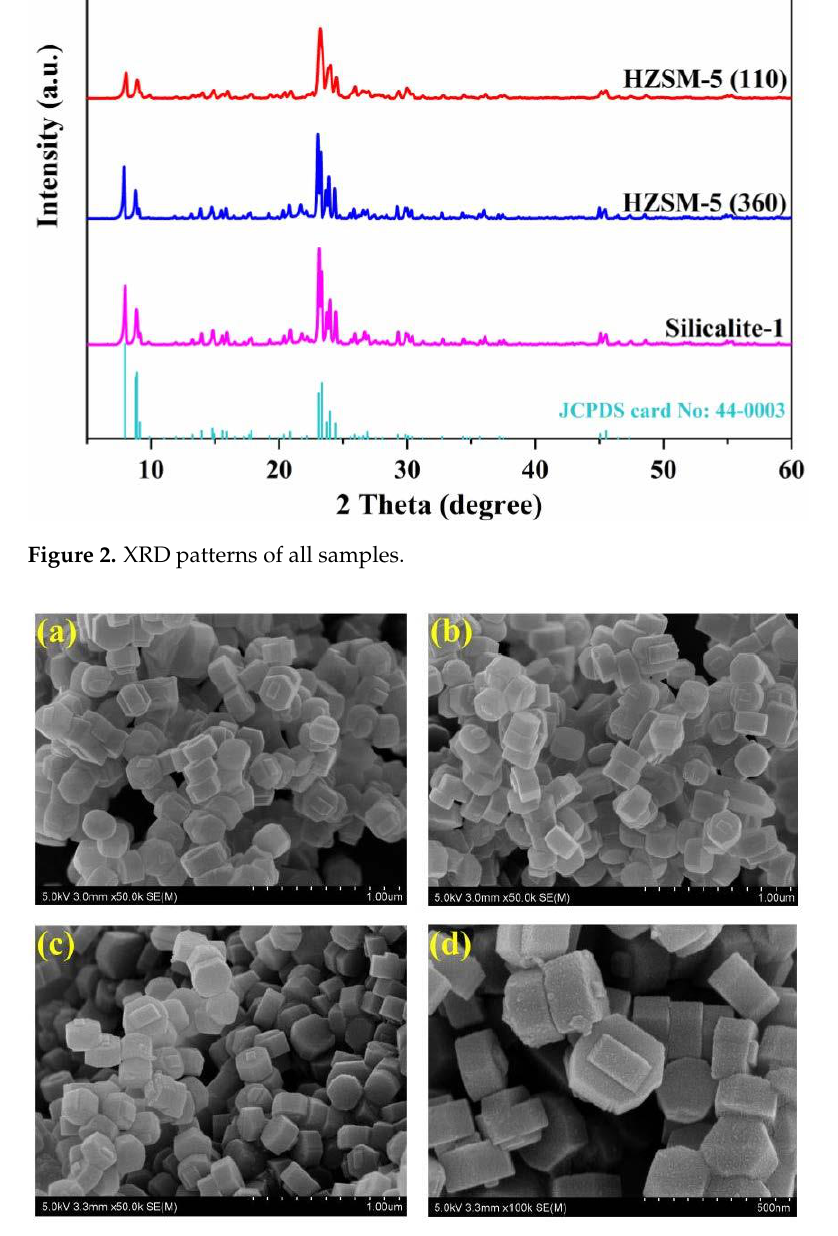
Figure 3. SEM images of all samples ( a ) HZSM-5(35), ( b ) HZSM-5(110), ( c ) HZSM-5(360), and ( d ) Silicalite-1.